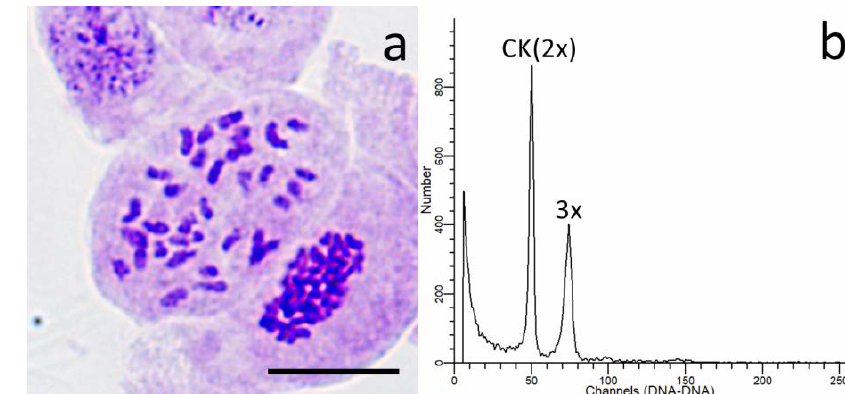
Figure 2. Ploidy level detection of offspring derived from megaspore chromosome doubling by colchicine treatment in Eucalyptus urophylla . ( a ) Somatic chromosome counting of triploid plant (2n = 3x = 33, scale bar = 10 μm). ( b ) Histogram presenting the flow cytometric analysis results. Table 3. Triploid production via megaspore chromosome doubling by colchicine treatment in Eucalyptus urophylla.